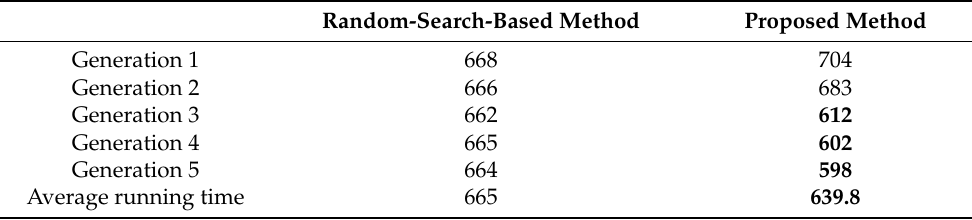
Table 6. Comparison of generational time required between the proposed method and the random search method.